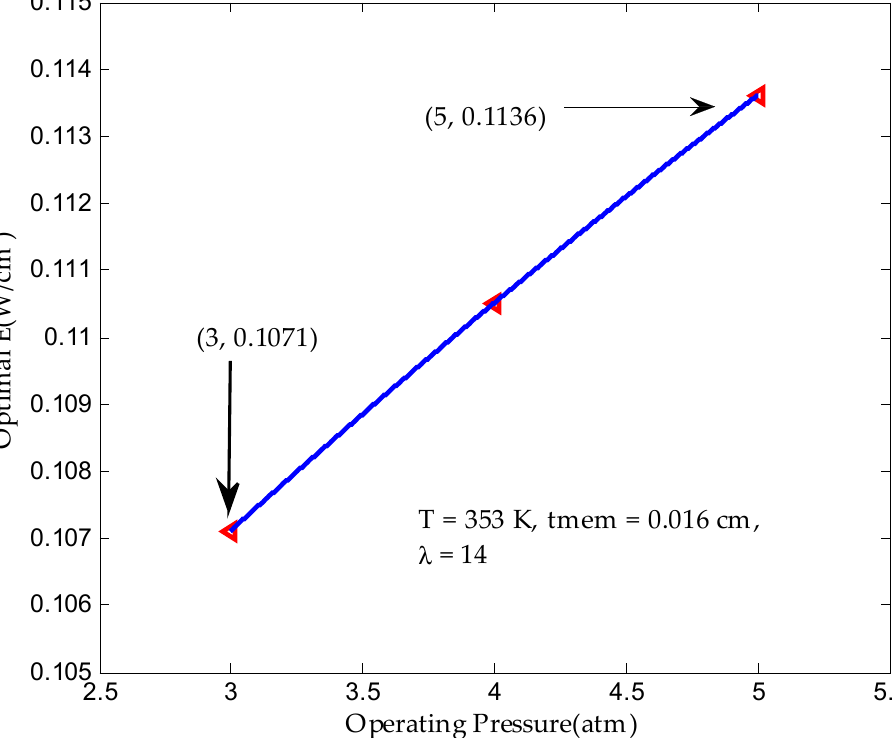
Figure 12. Optimal ecological objective function varying with operating pressure.